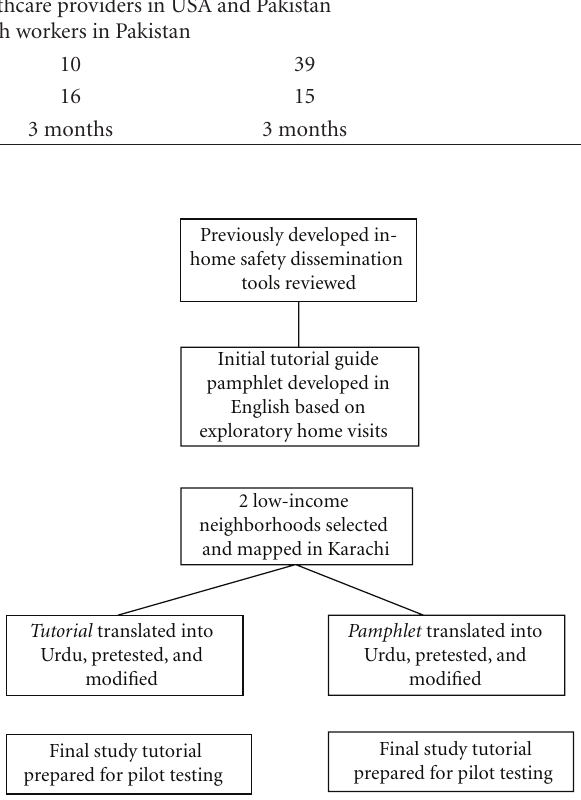
Figure 2: Process of development of new tools for child injury risk